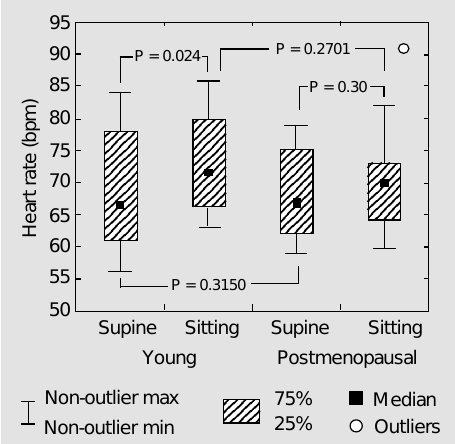
Figure 5. Mean heart rate, in bpm over a period of 6 min for the young group (N = 10) and the postmenopausal group (N = P = 0.30 10) under resting conditions in the supine and sitting